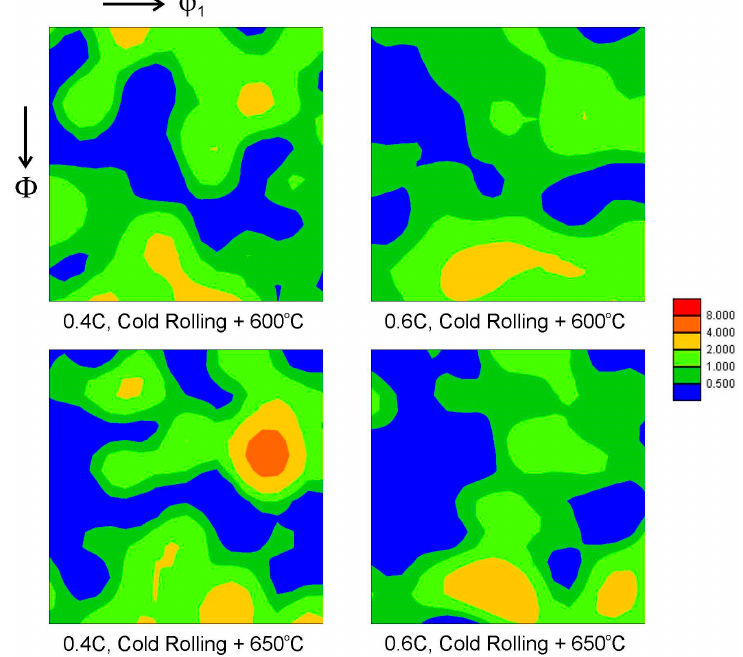
Figure 5. Orientation distribution functions at ϕ 2 = 45 ° for Fe-0.4C-18Mn and Fe-0.6C-18Mn steels (0.4C and 0.6C, respectively) subjected to cold rolling and annealing at indicated temperatures.